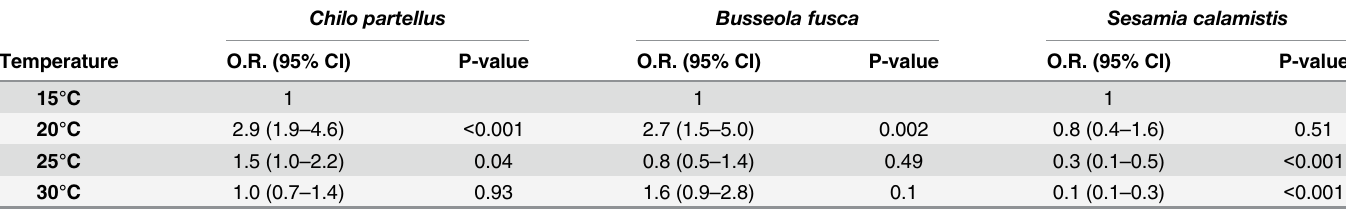
Table 1. Results of GLM analysis comparing larval survival of each single-species at different constant